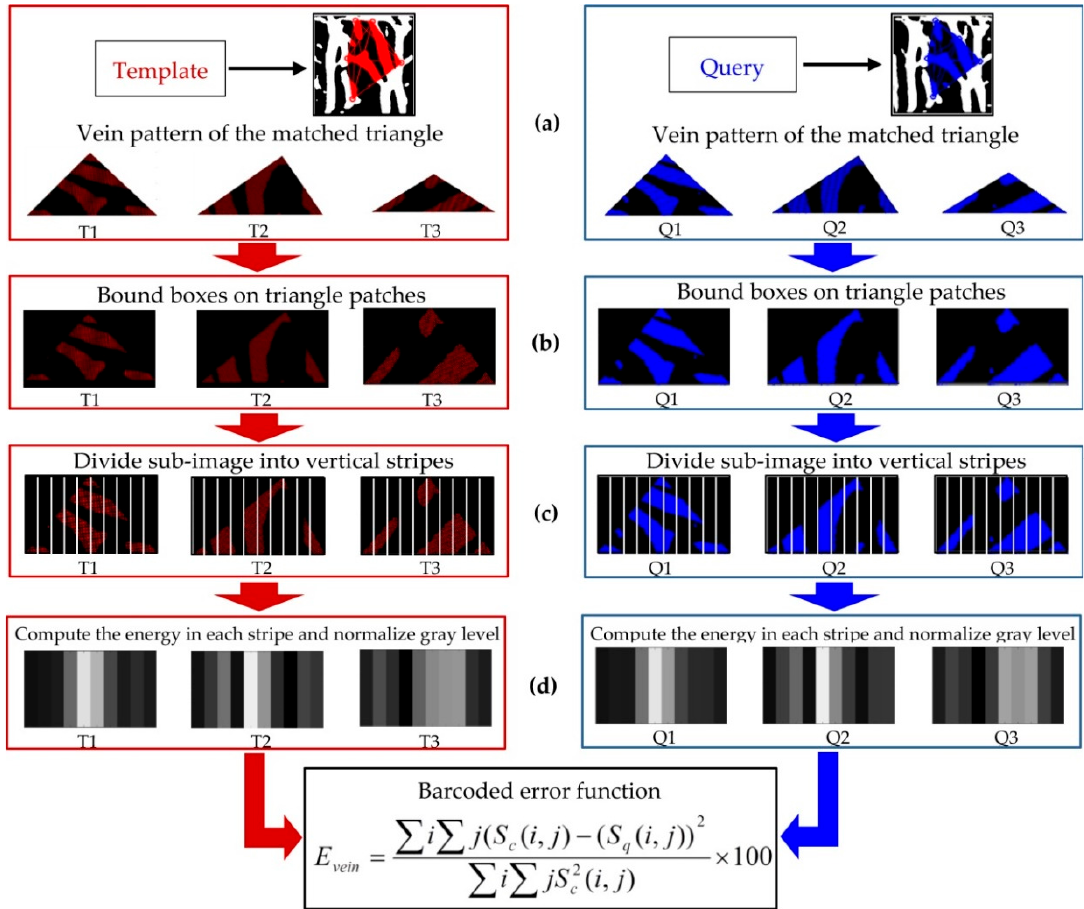
Figure 21. Barcoded features;.( a ) Vein pattern images are capsulated by the corresponding query and candidate triangles. ( b ) Square boxes are then bounded on the triangle patch. ( c ) Each sub-image is then divided into ten vertical stripes. ( d ) Compute the energy in each stripe, normalize them into gray level and input the computed gray level into the corresponding stripe .